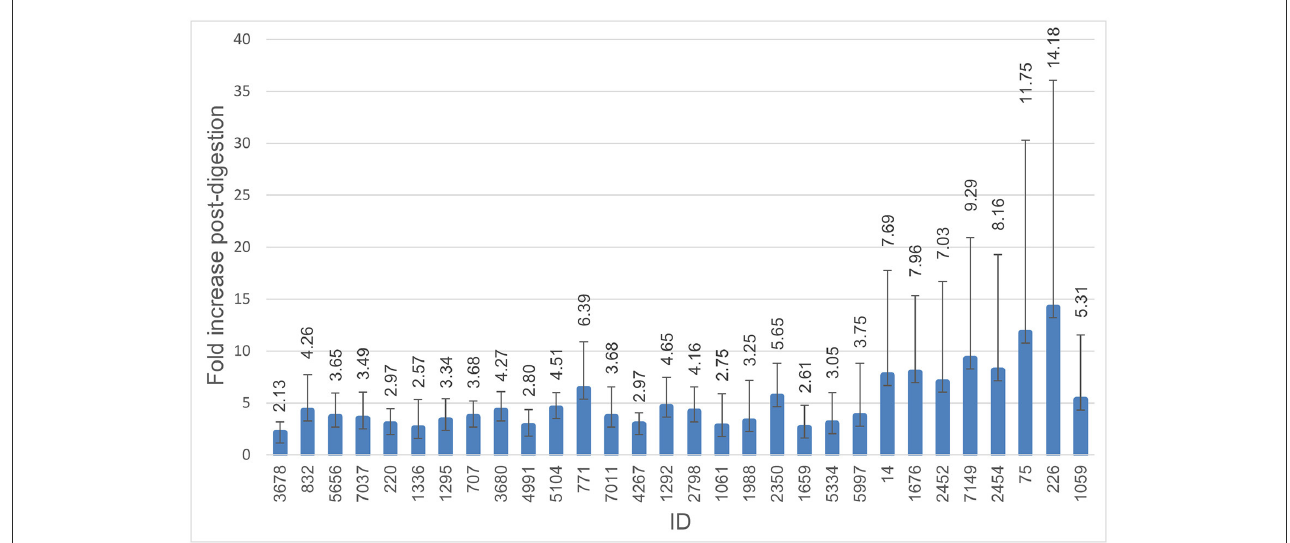
FIGURE1 Survival through digestion. Histogram demonstrating fold-increase in CFU/ml after digestion compared to non-digested. The error bar represents the standard deviation. All isolates were able to survive digestion, and all were able to continue growth during the digestion process. Isolate 3,586 was excluded from this figure due to a failure of growth in the non-digested control.